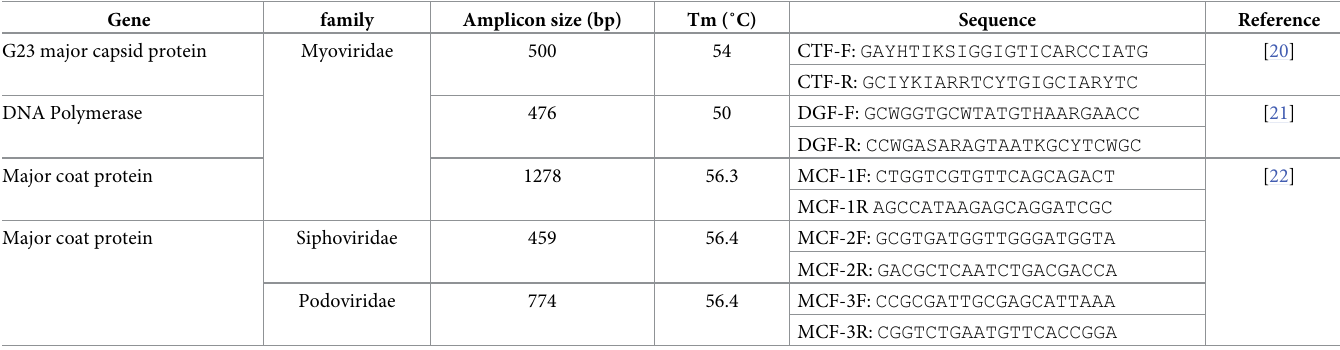
Table 1. PCR primers used in phage isolation. Gene